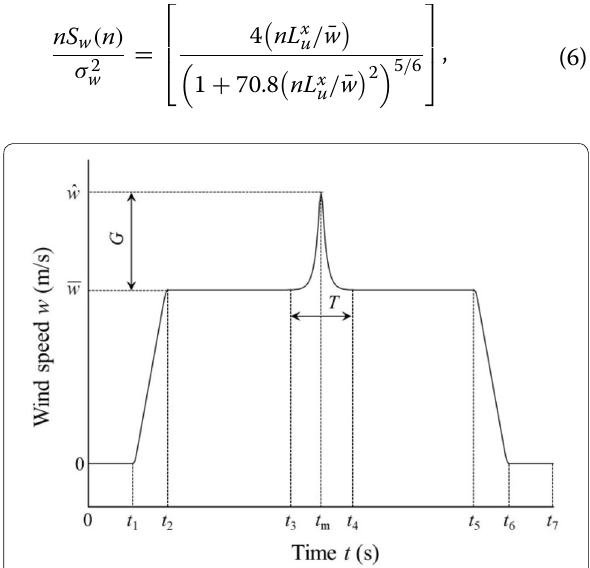
Figure 1 Ideal wind gust